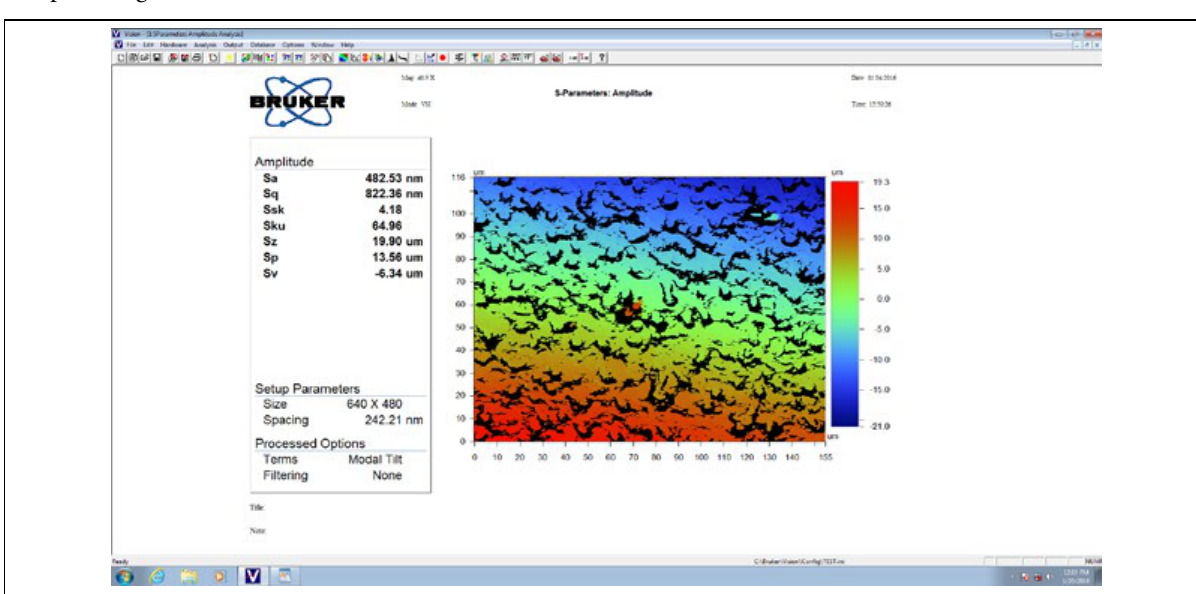
Figure 2. Sample epoxy replica of the studied teeth.